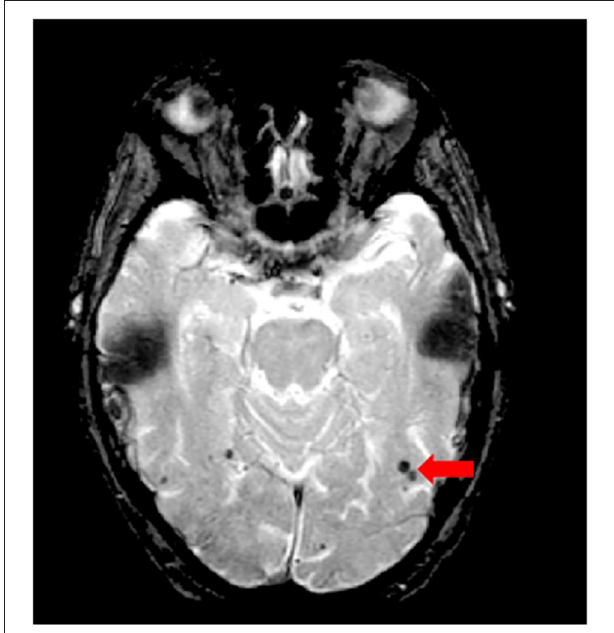
FIGURE 11 | Axial view of iron-sensitive T2* gradient echo (GRE) with red arrow pointing to cerebral microbleeds visualized as hypointensities (dark).